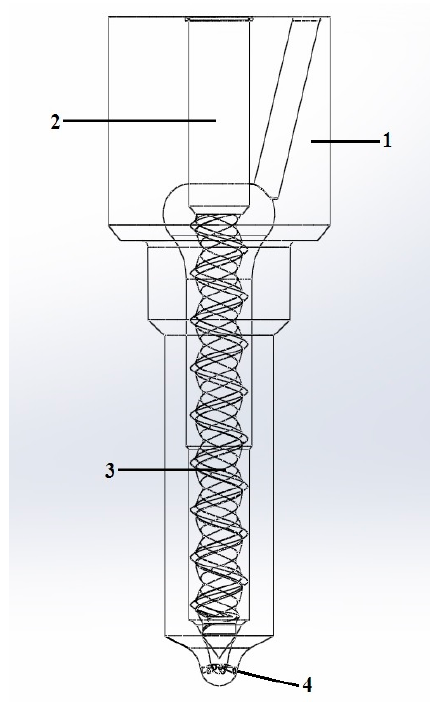
Figure 2. Modified fuel injector atomizer: 1—case, 2—precise needle pair, 3—spiral-elliptical channels made on the inoperative part of the needle with a catalytic reactor, 4—injection holes.